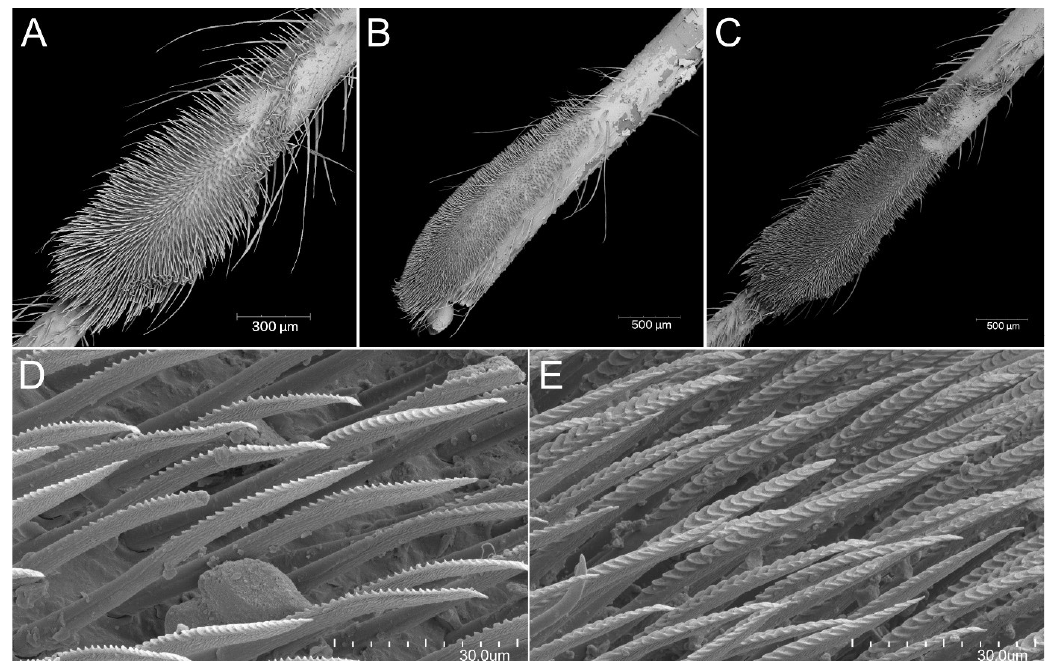
Whereas from the fourth instar, two small appendages form in the middle of the hind femur (Figure 25F).